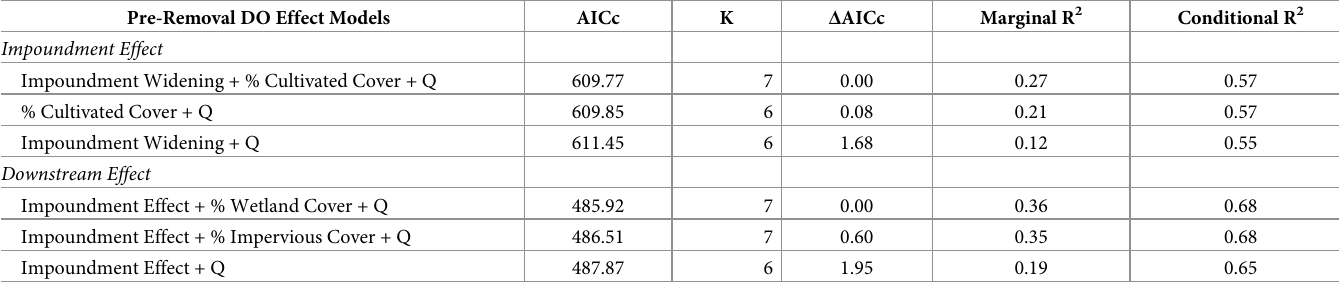
Table 6. Summary of highly ranked models ( Δ AICc � 2.0) explaining the variation in impoundment and downstream mean dissolved oxygen (DO) effects prior to dam